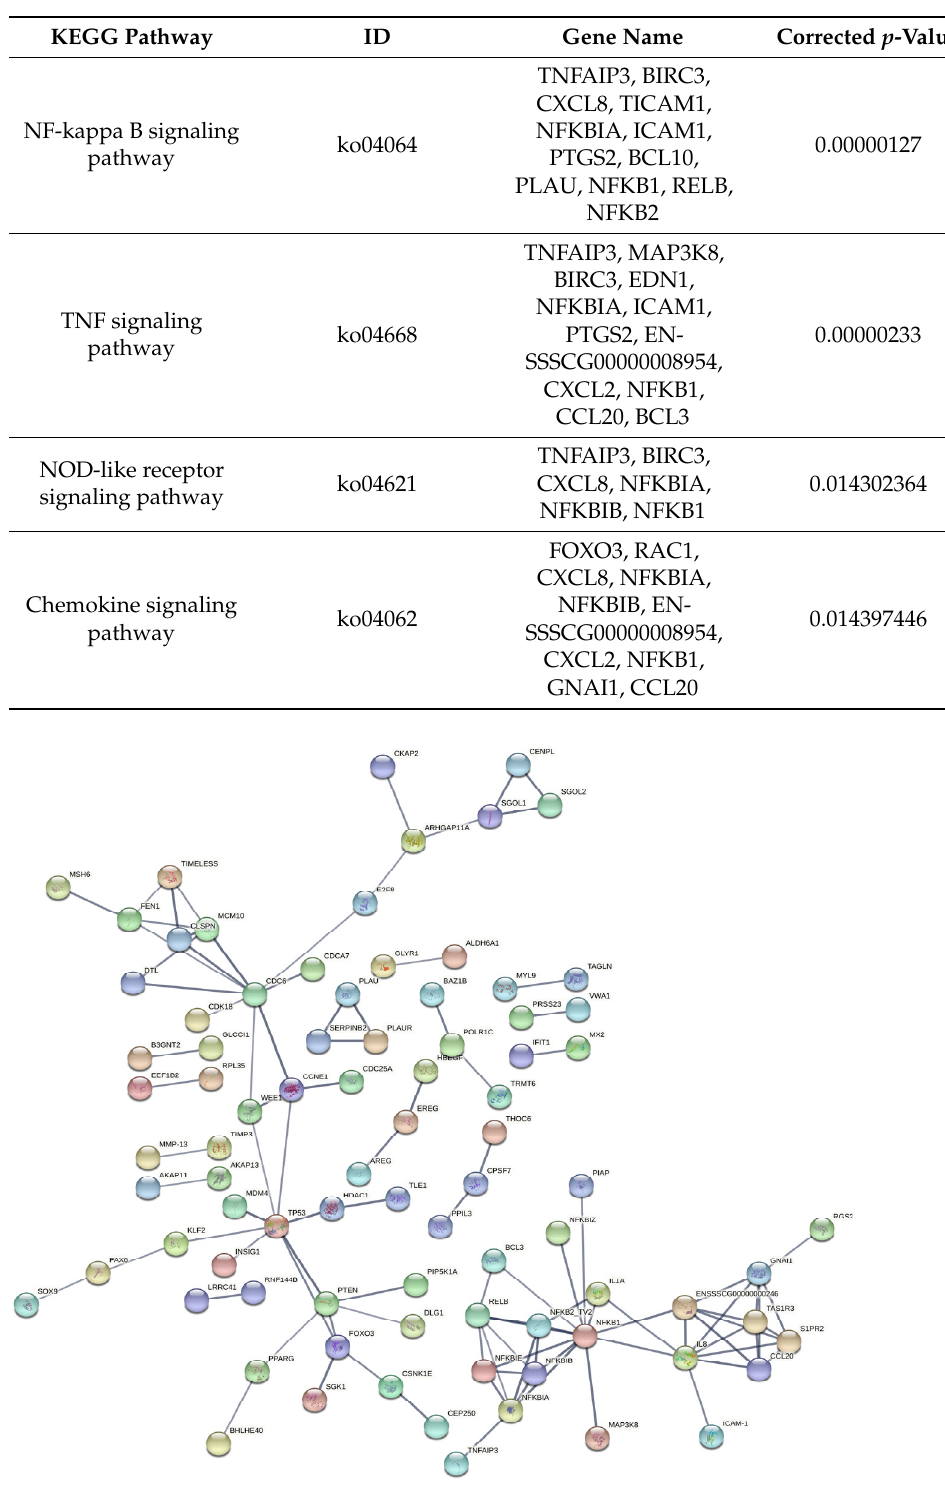
Figure 4. PPI analysis of DEGs in the control and E. coli groups.